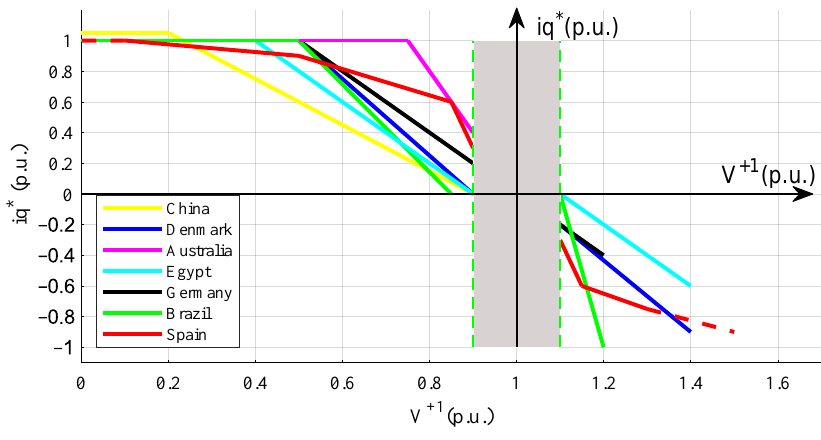
Figure 8. Dynamic reactive current injection curve as established in different grid